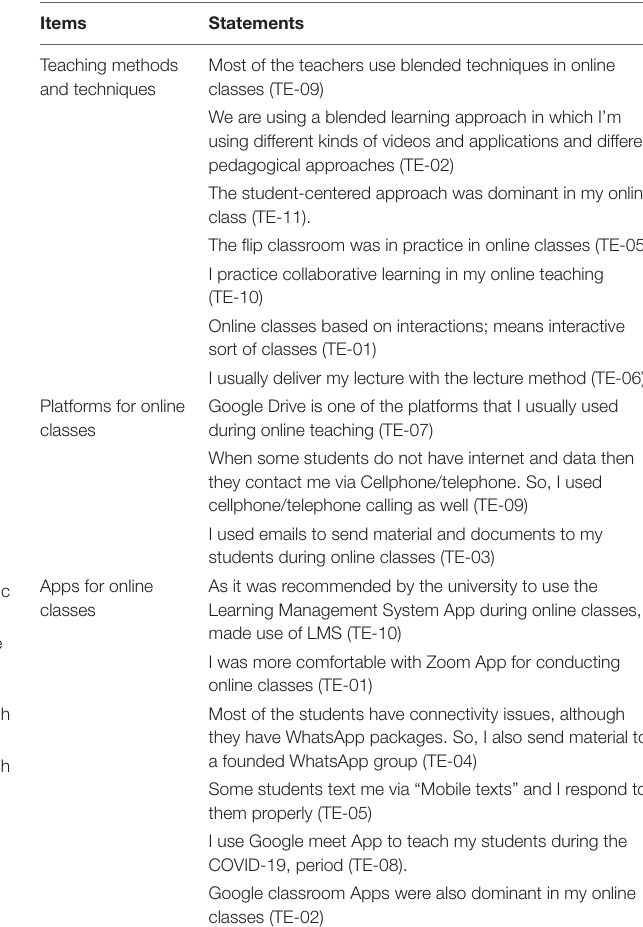
TABLE 4 | Teaching instructions, software applications, and platforms used for online